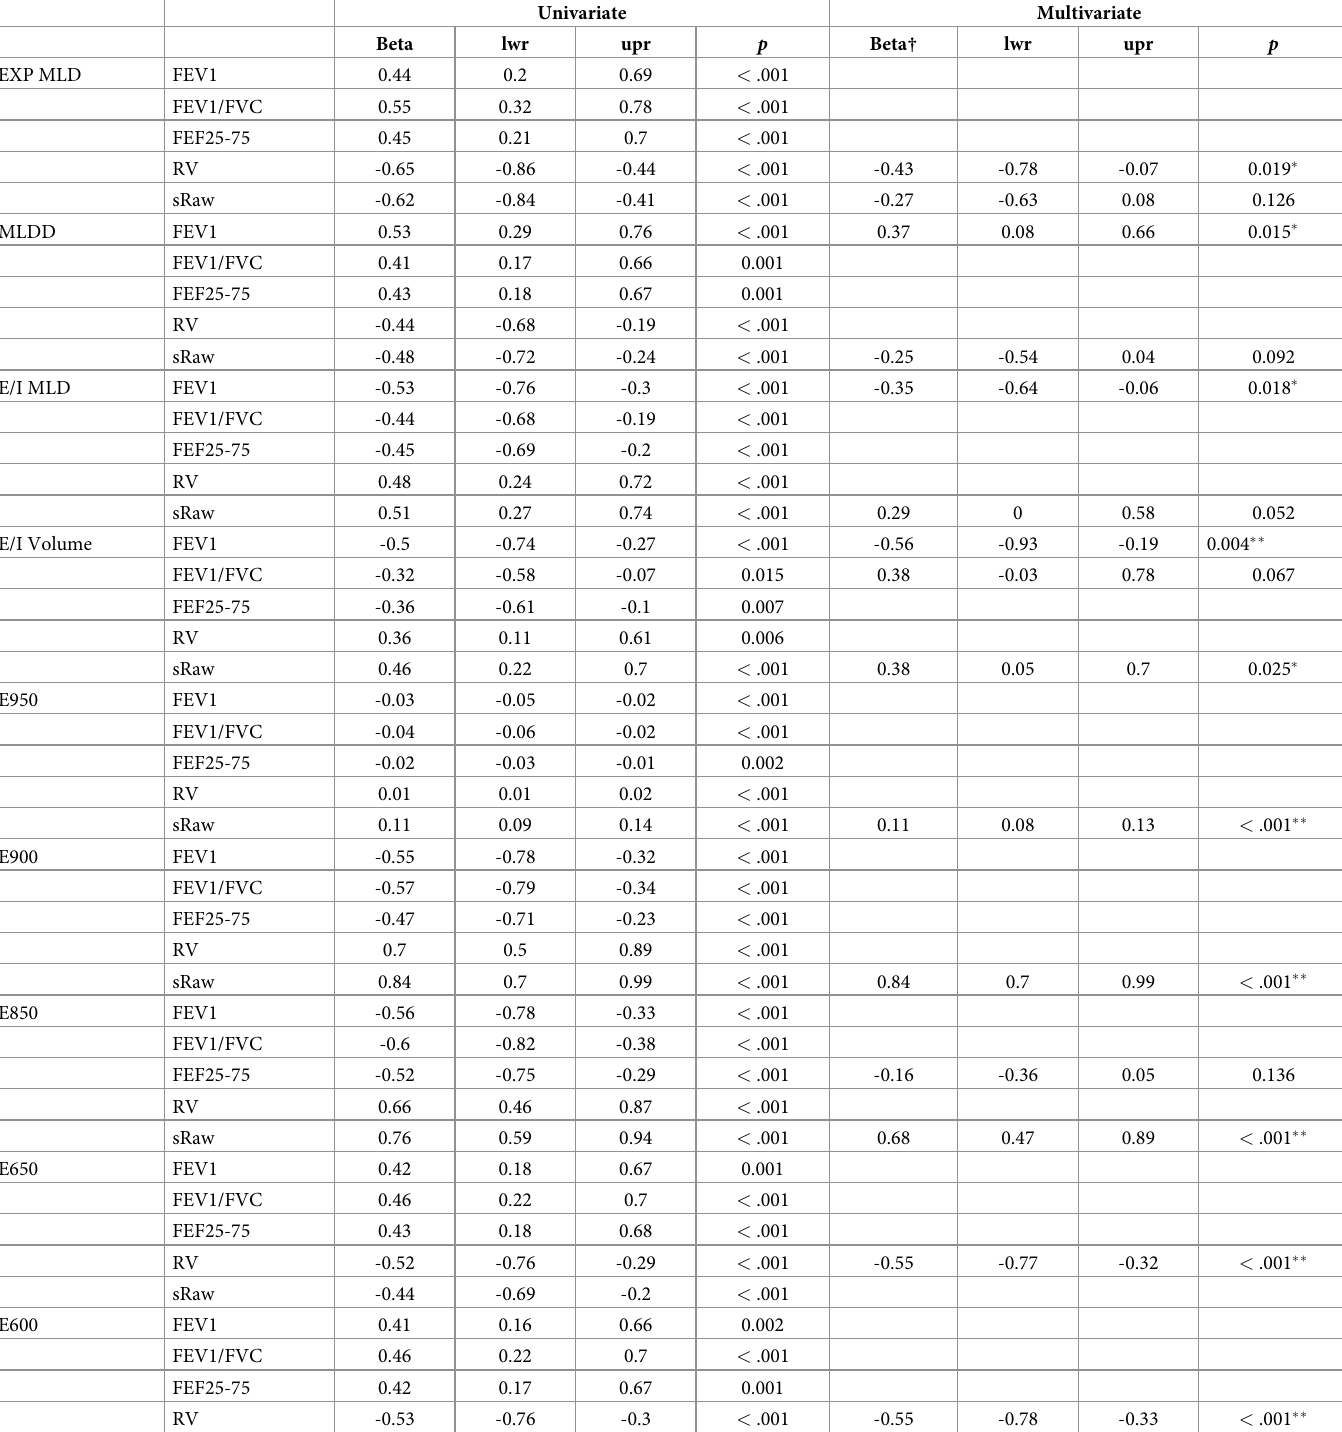
Table 2. Univariate and multivariate linear regression for lung density indices (LDIs) with conventional